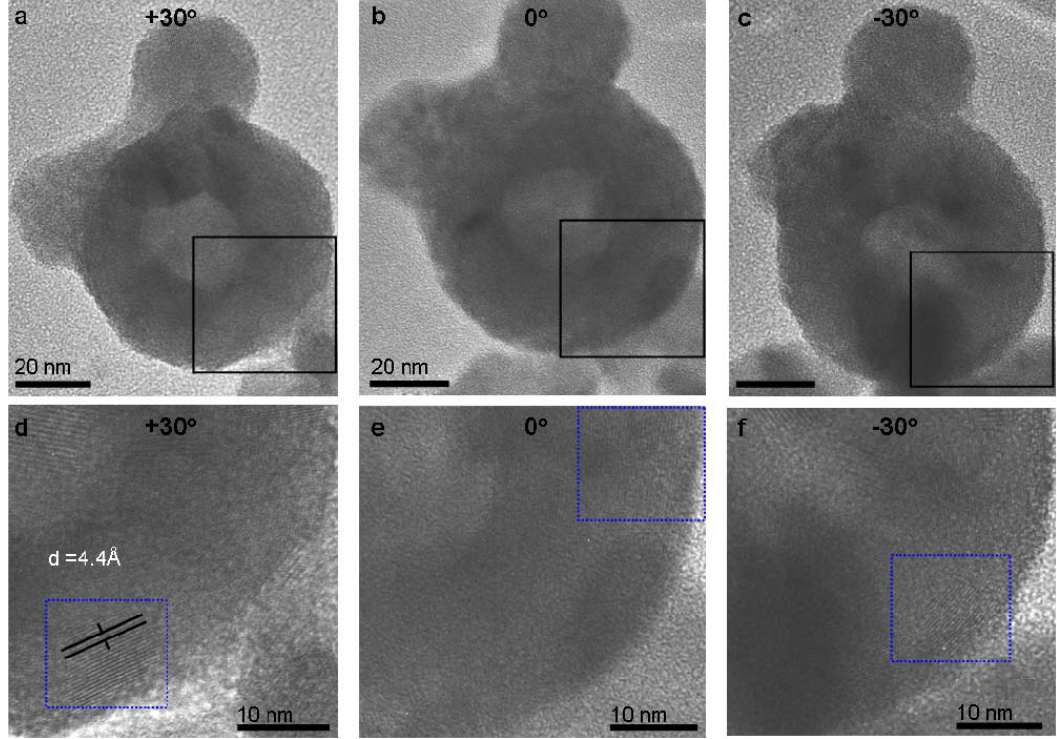
Figure 5. TEM images of NP tilted at (a) +30°, (b) 0° and (c) − 30° with the frames in close-up (d,e,f) . The blue dashed frame highlights fringes which appear at specific tilt angles. The spacing corresponds to that of the vdW gap (4.4